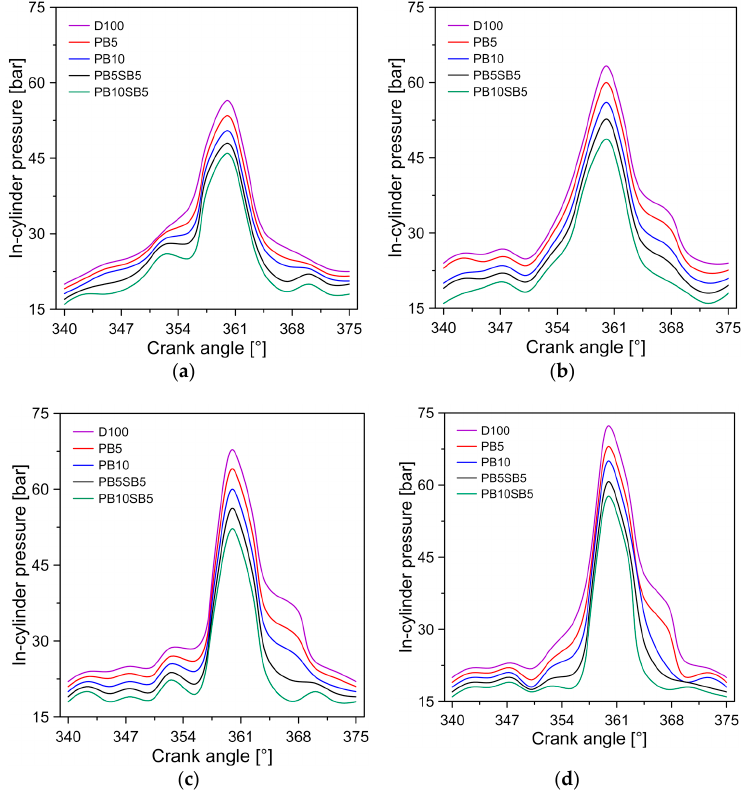
Figure 5. Influence of fuel on cylinder pressure for ( a ) mode A, ( b ) mode B, ( c ) mode C, and ( d ) mode D.